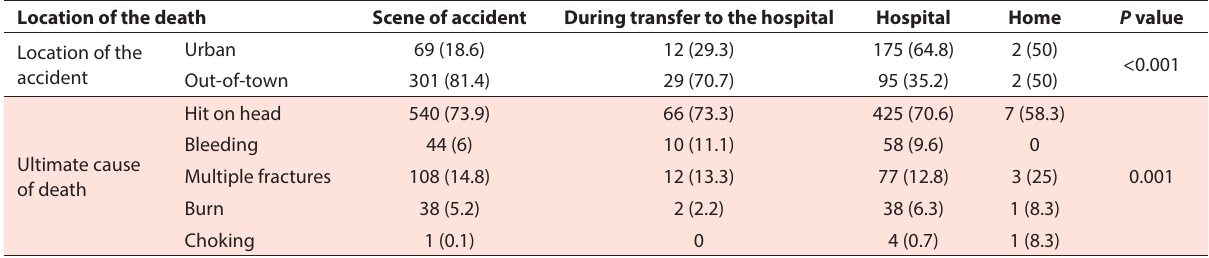
Table 2. The relationship between location of the death with the location of the accident and ultimate cause of death Location of the